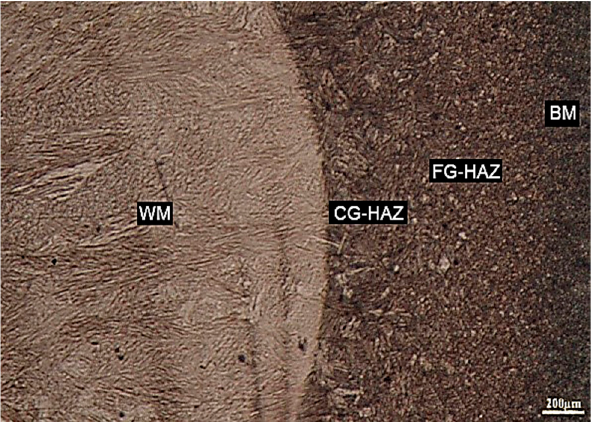
Figure 3. Optical image of weld region in sample No. 5 with a heat input of 2.229 kJ/mm showing WM, HAZ, and base metal.